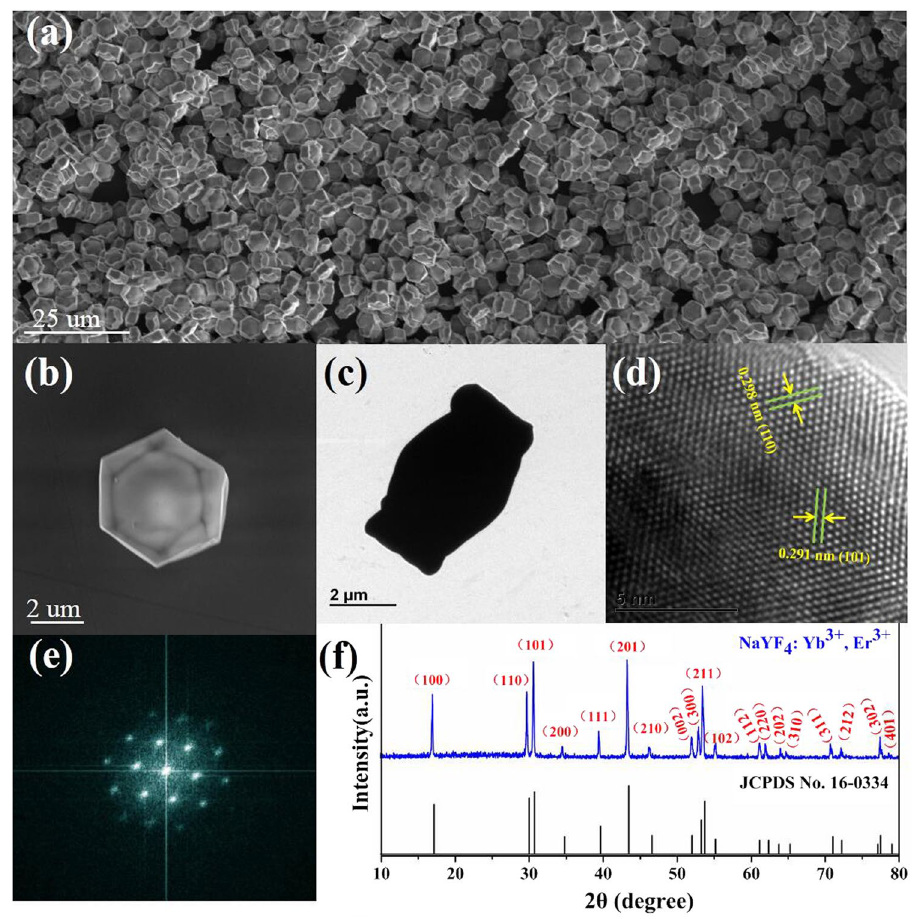
Figure 1. ( a ) SEM image of the as-synthesized peculiar-shaped NaYF 4 : 20% Yb 3 + /2% Er 3 + hexagonal microcrystals. ( b ) SEM image of the single microcrystal. ( c ) TEM image of the single microcrystal. ( d ) HRTEM image of the microcrystal. ( e ) Corresponding Fourier transform diffraction pattern of the HRTEM. ( f ) XRD pattern of the microcrystal and literature data for hexagonal phase NaYF 4 (JCPDS file number